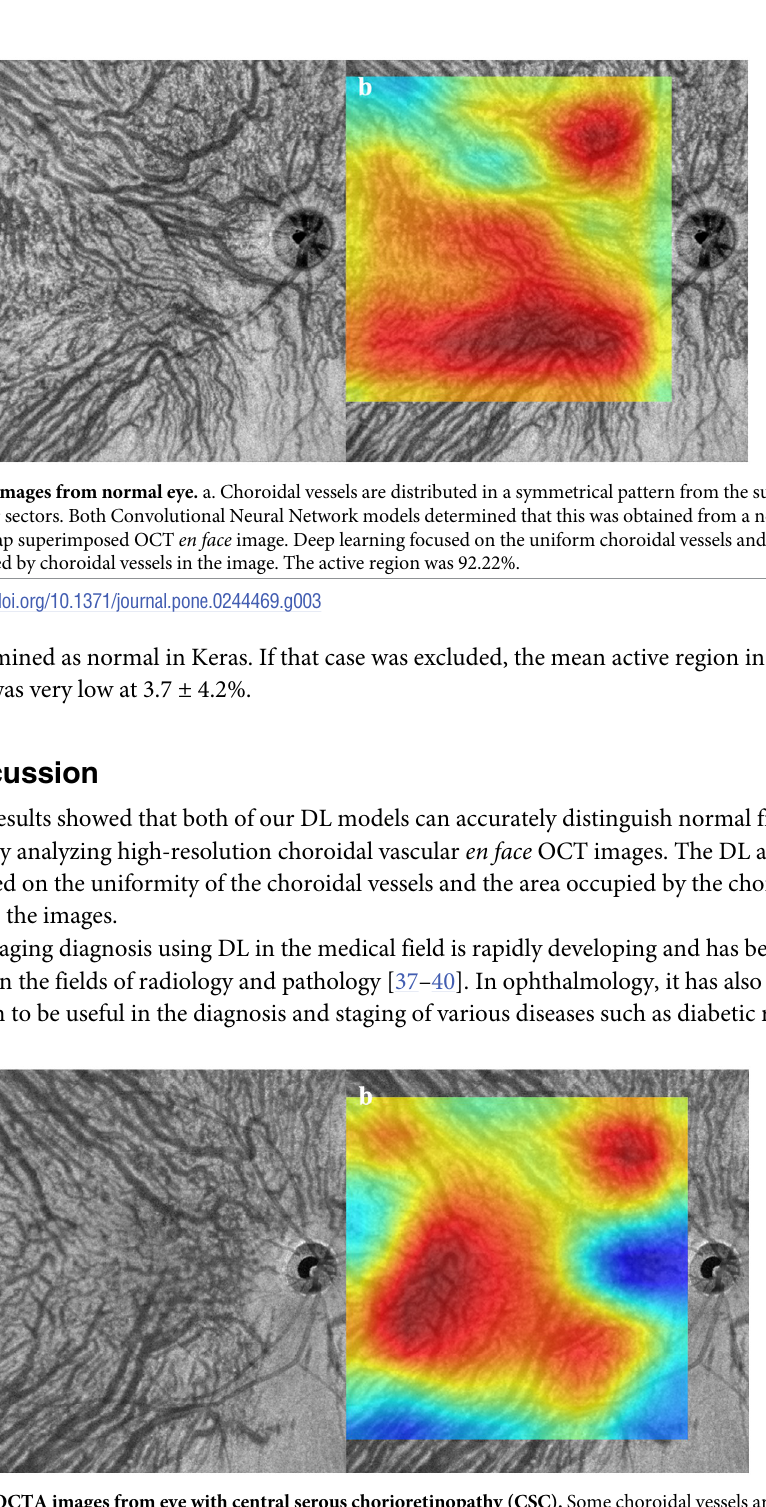
Fig 4. OCTA images from eye with central serous chorioretinopathy (CSC). Some choroidal vessels are dilated, and the vascular density is high. However, the choroidal vessels are distributed in a vertically symmetrical pattern. The NNC model determined that this image was from a CSC eye, but the Keras model judged from a Normal eye. b. Heatmap superimposed on OCT en face image. DL focused on the uniformity of the choroidal vessels and the area occupied by the choroidal vessels in the image. The active region is 74.24%.